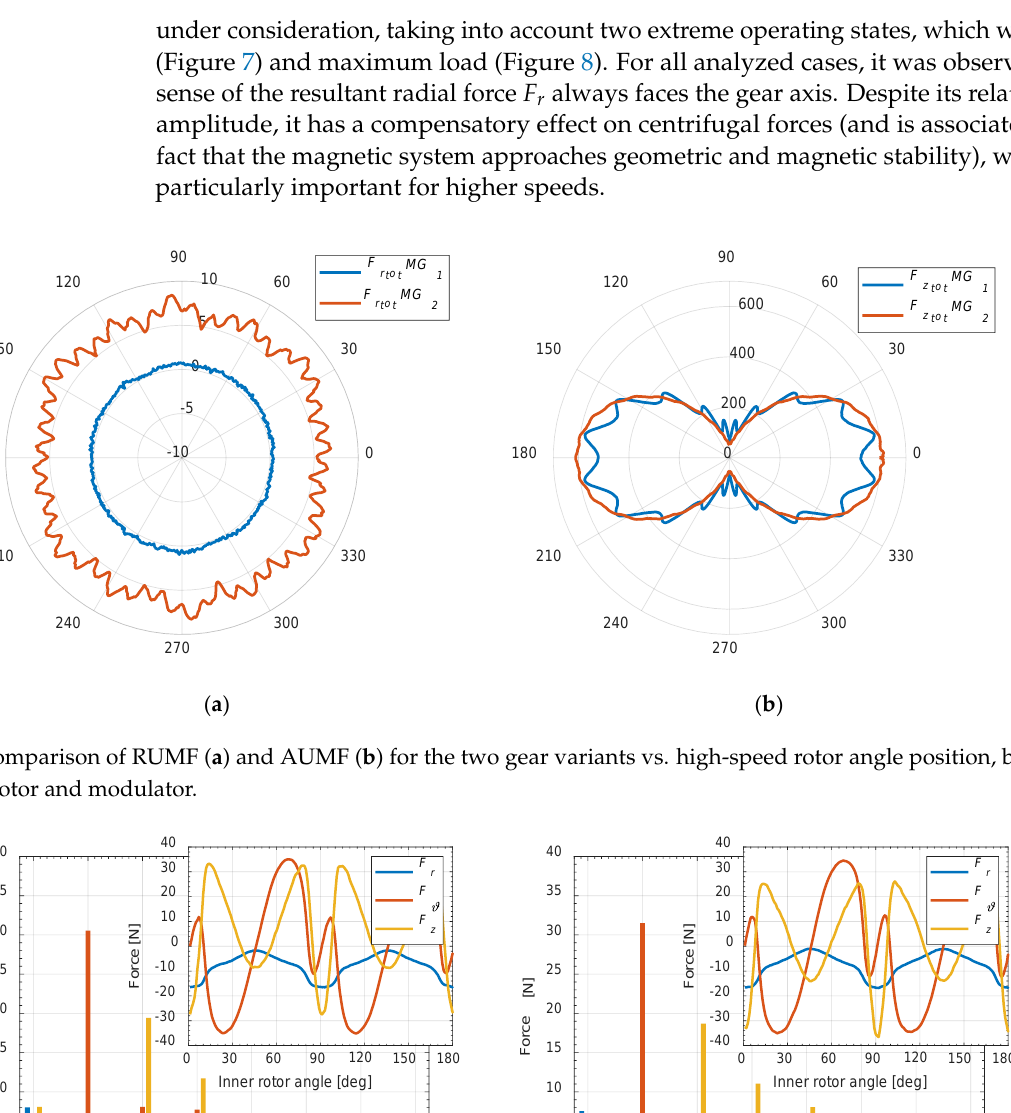
Figure 8. Force components acting on a selected SMC modulator core and their FFT spectra at max. load for two gear variants: ( a ) MG 1 ( b ) MG 2.